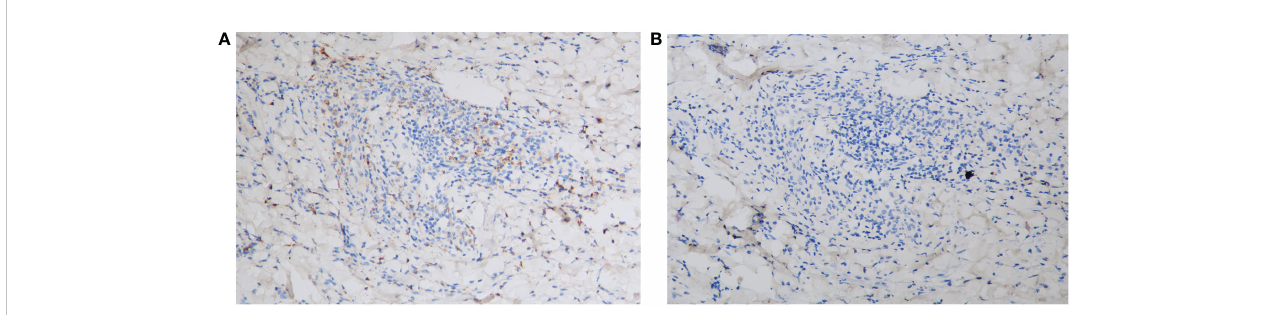
FIGURE 3 Immunohistopathology of the skin biopsy specimen. (A) The monoclonal k -light chain was positive (×200). (B) The monoclonal l chain was negative (×200).